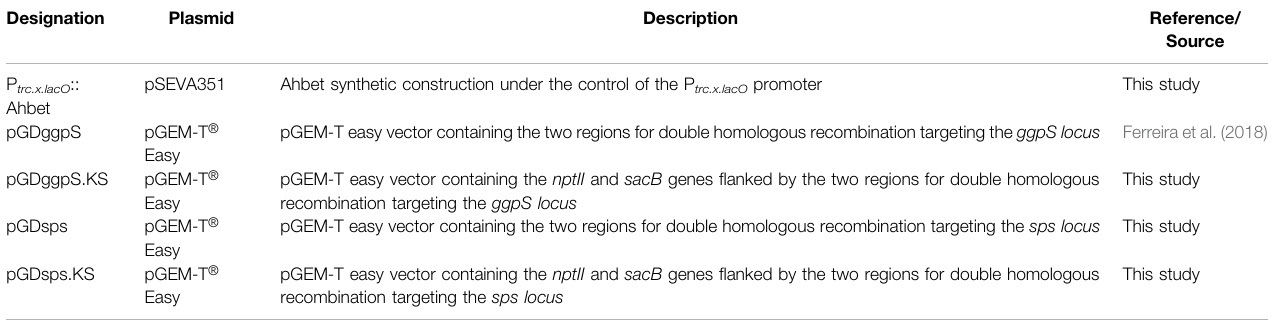
transformants by PCR using speci fi c primers (Additional fi le 1: Supplementary Table S4 ), as described by Ferreira et al. (2018).